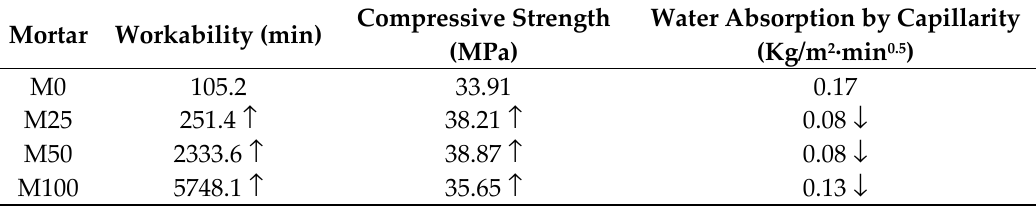
Table 2. Mortar characterization